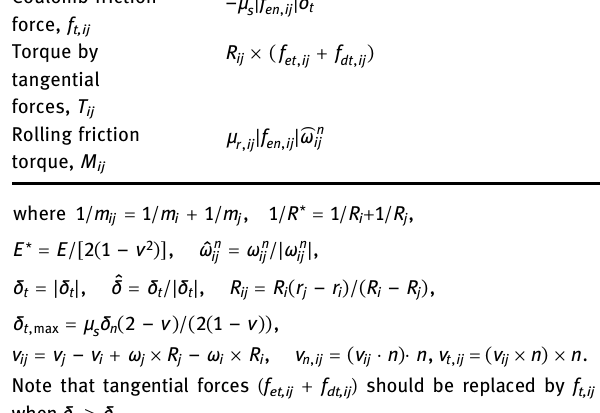
Table 1: The equations of particle – particle interaction forces and moments Force and torque Equation Normal elastic force, f en,ij Normal damping Tangential elastic force, f et,ij Tangential damping force, f dt,ij Coulomb friction